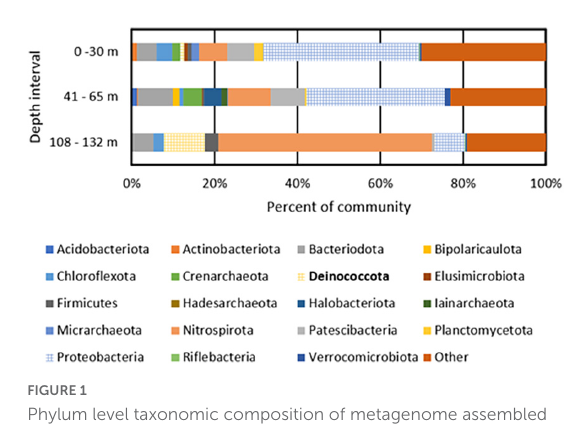
FIGURE1 Phylum level taxonomic composition of metagenome assembled genomes (MAGs) recovered from BA1A filtered biomass from discrete depth intervals. MAGs that encode homologs of enzymes or enzyme complexes that allow for the respiration of oxygen (Cox I and II, CydABX) are depicted with a grid pattern. Deinococcota, the phylum containing Meiothermus , is bolded in the